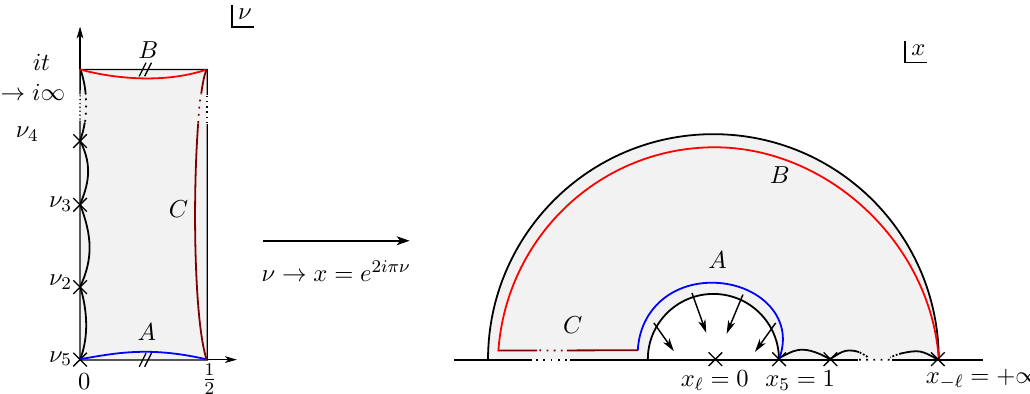
Figure 2 . Mapping of the annulus to the plane with x = e 2 i(cid:25)(cid:23) in the t ! 1 limit. In the reduction of the blue contour onto the real axis, a singularity at x = 0 is